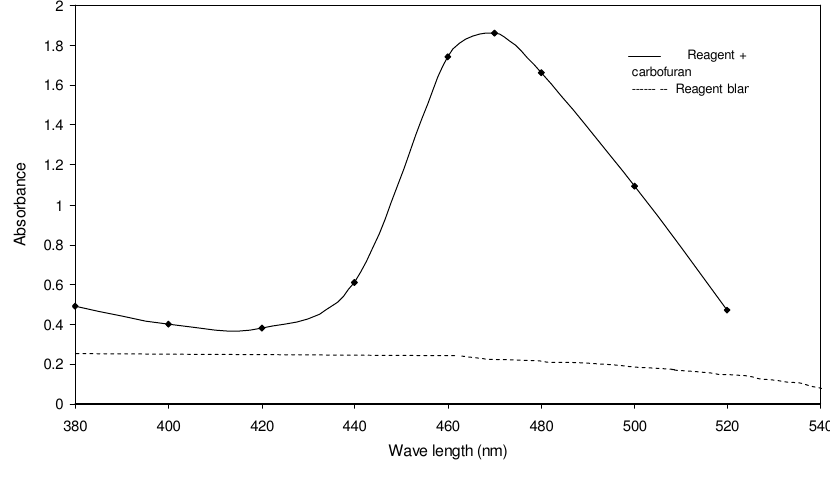
Fig 1 Absorption spectrum of carbofuran derivative